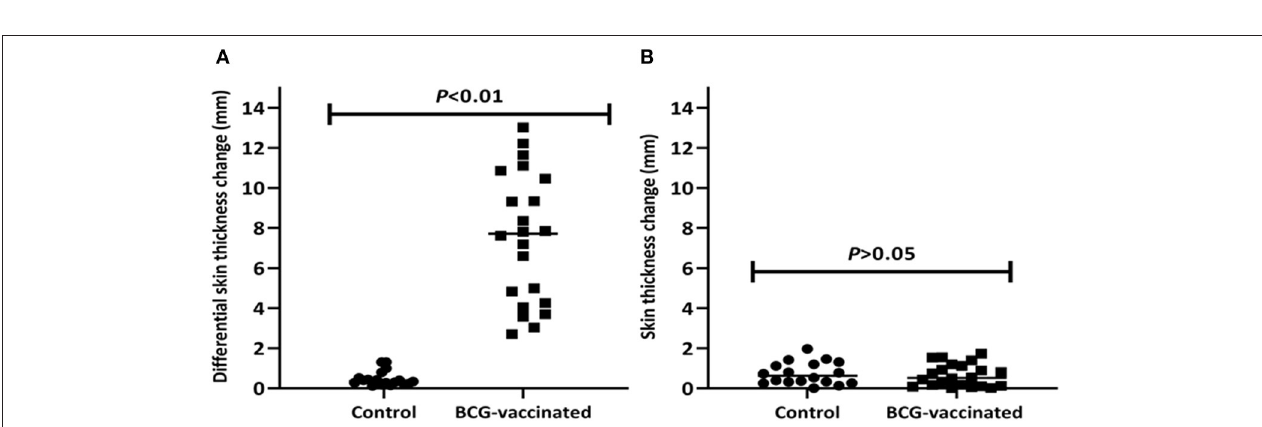
FIGURE 2 | Post-vaccination skin test responses in the experimental calves. The figure shows skin reaction to the PPD (B-A) (A) and to the DIVA proteins cocktail (B) in individual vaccinated and control calves after vaccination. The individual animal result is represented by a solid circle for the control group and a solid square for the vaccinated group, and medians are indicated by horizontal lines. The change in skin thickness due to the PPD (B-A) was significantly ( p < 0.01) higher in the vaccinated calves than in the control calves while the change to the DIVA proteins cocktail was not observed in both groups of calves.